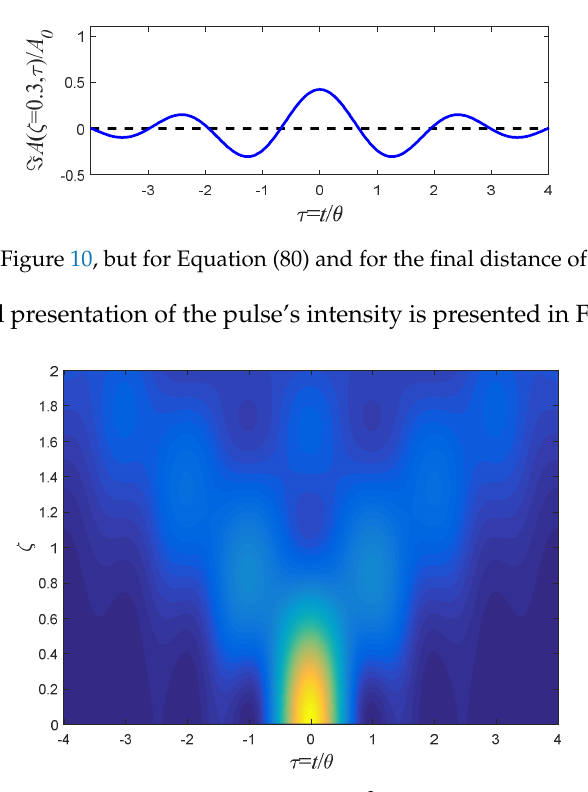
2 , ztA ) of the pulse presented by Equation (80).